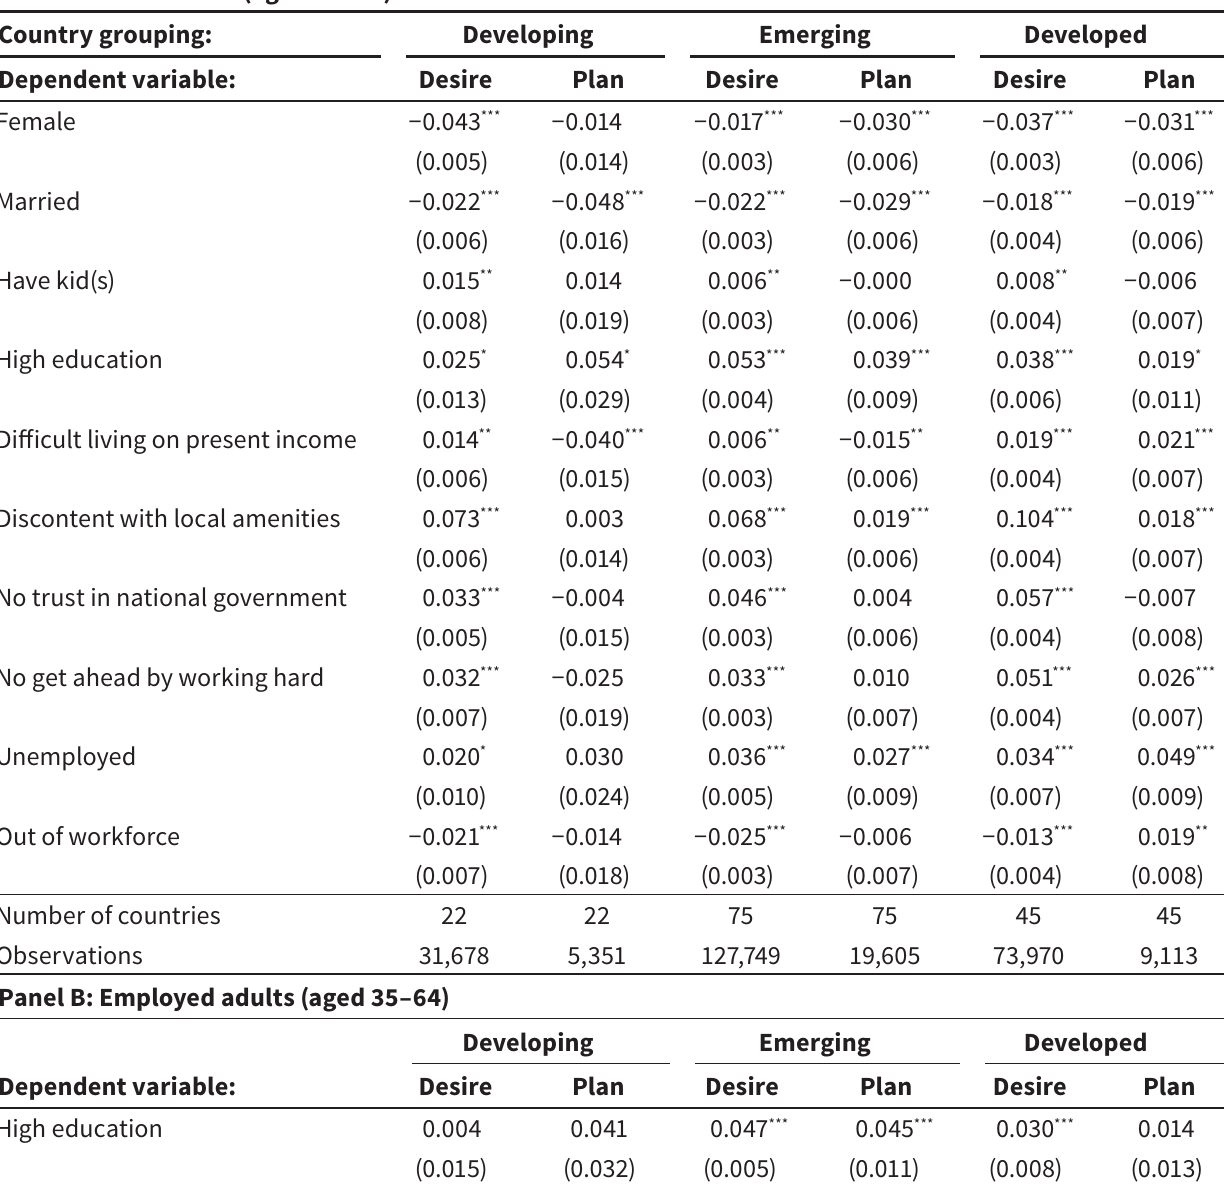
Adults desire/plan to migrate abroad, selected